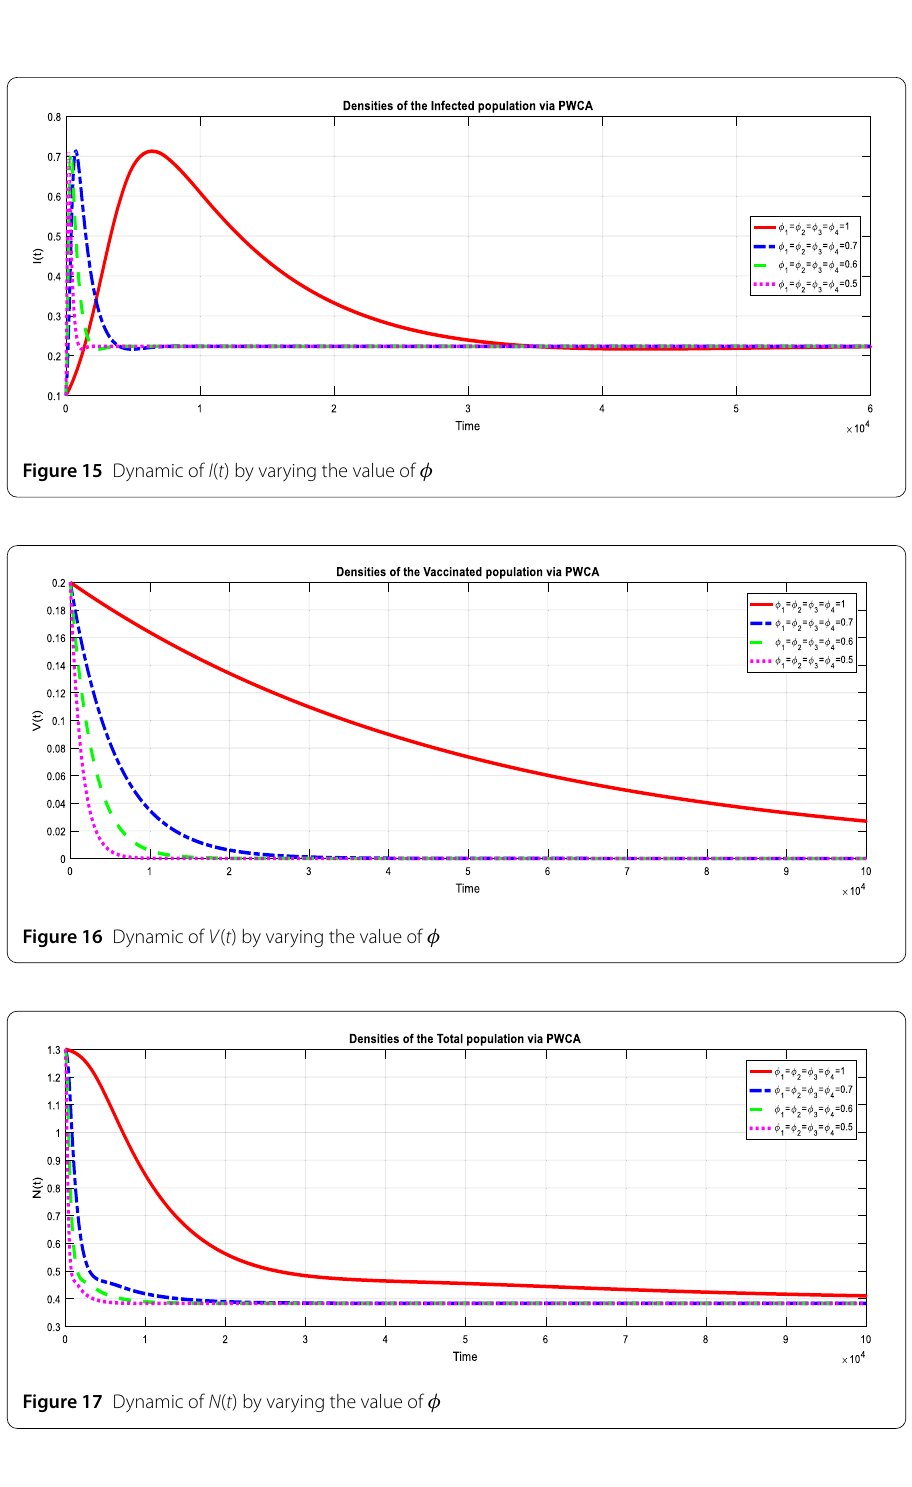
for j = 0,1,2,..., ℵ – 1. If the step size h is selected small enough, then we may neglect the second order term (involving h 2 α ) and develop